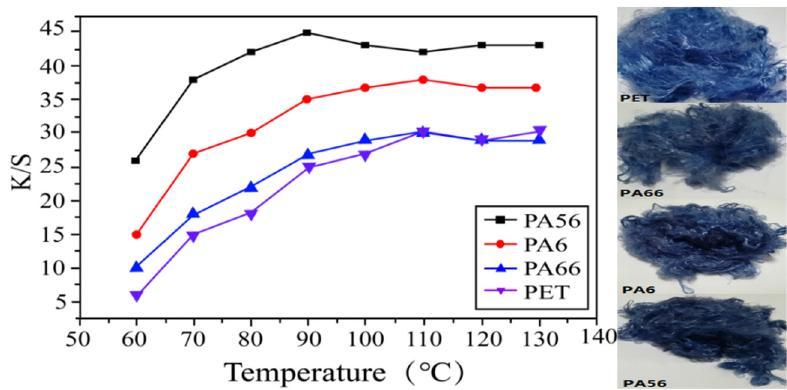
Figure 3: Dyeing property of metal complex dyes for several kinds of fi bers ( 44 dtex/36 f FDY ) .